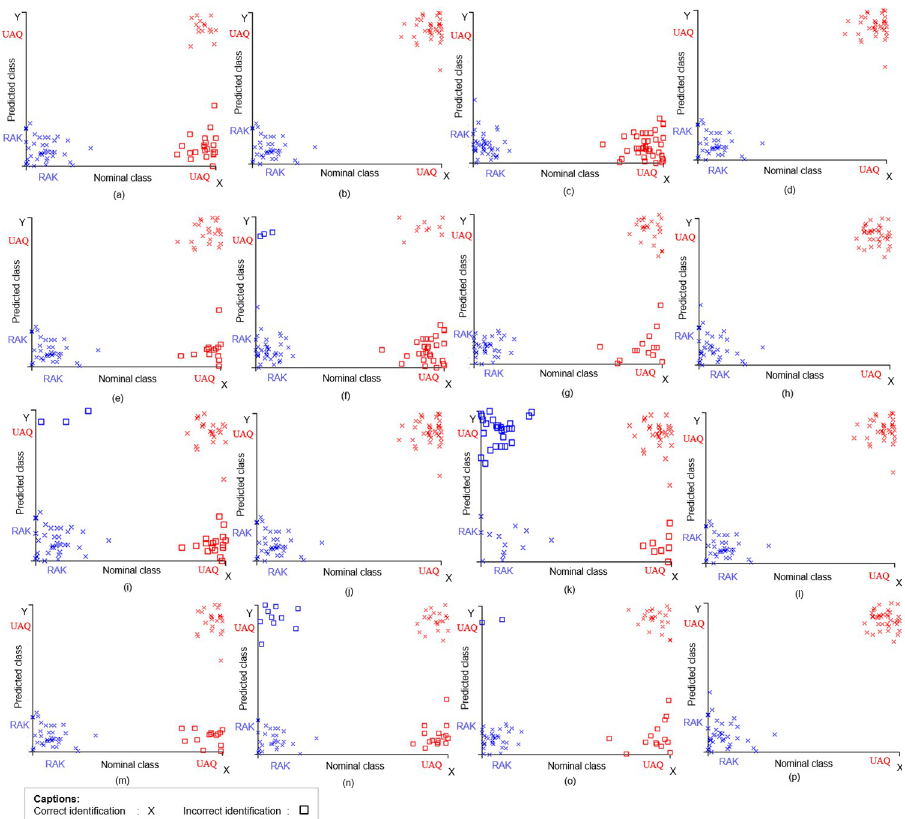
Fig 4. Scatter plot representing the nominal and predicted distribution of the individuals across the sampling sites (RAK and UAQ). (I) Alignment based datasets analyzed using SML’s SMO classifier (a) rbcL (b) matK (c) psbA- trnH (d) cpDNA (e) ITS2 (f) ETS (g) nrDNA (h) cpDNA+nrDNA. II) Alignment free datasets analyzed using SML’s SMO classifier (i) rbcL (j) matK (k) psbA-trnH (l) cpDNA (m) ITS2 (n) ETS (o) nrDNA (p) cpDNA+nrDNA.